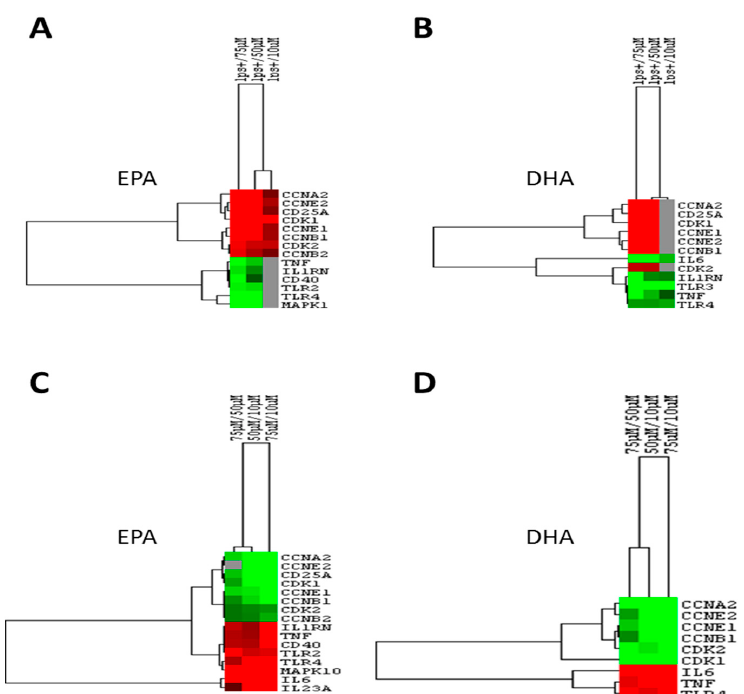
Figure 5. Panels ( A ) and ( B ) represent gene expression differences in LPS-stimulated macrophages (LPS+) versus LPS+ macrophages plus 10, 50 and 75 µM EPA or DHA. Panels ( C ) and ( D ) show comparisons in gene expression levels for different omega-3 ( n -3) fatty acid (FA) concentrations. CCN: cyclin, CDK: cyclin-dependent kinase 2.